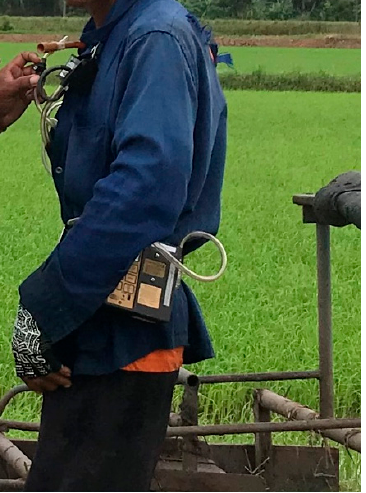
Figure 4. Particulate matter sampling application.